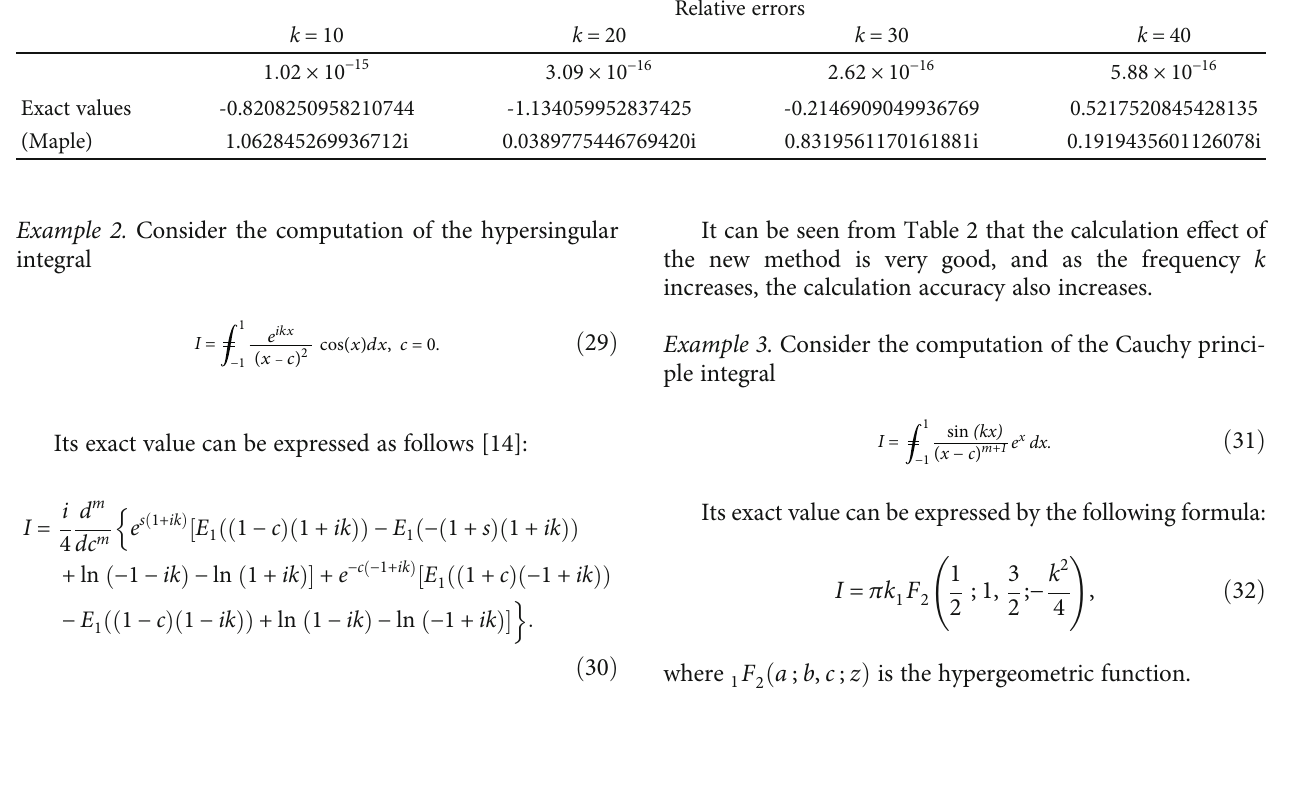
Table 4: Relative errors of the direct steepest descent method for .